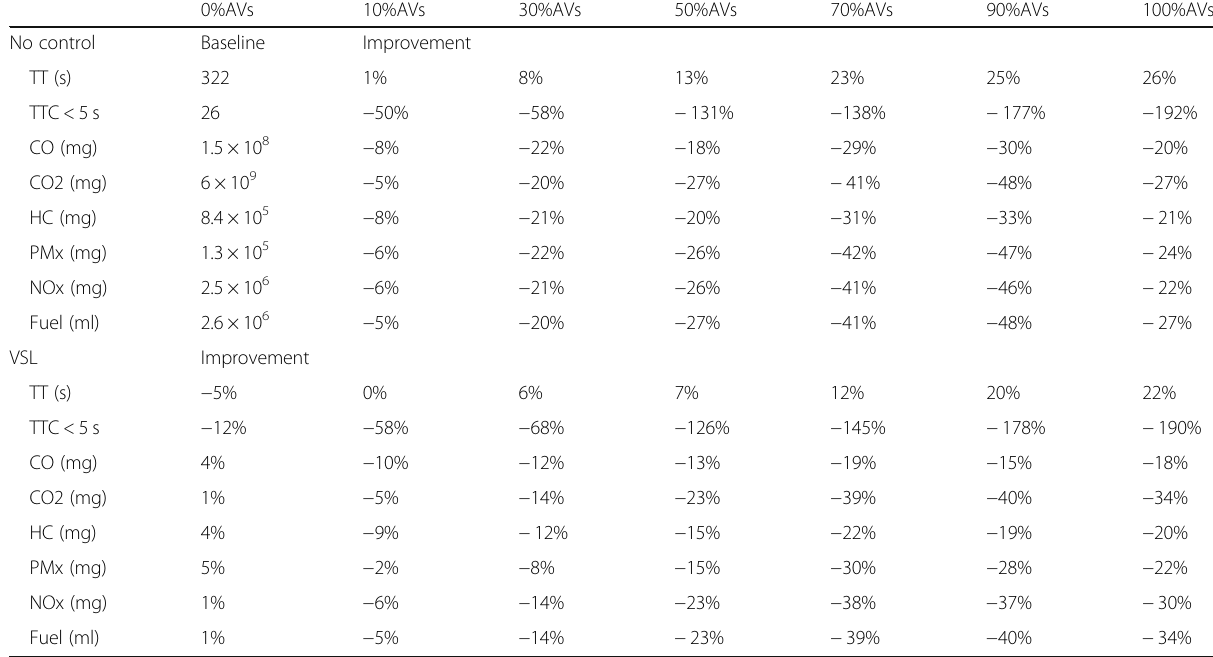
Table 4 MoEs computed using future